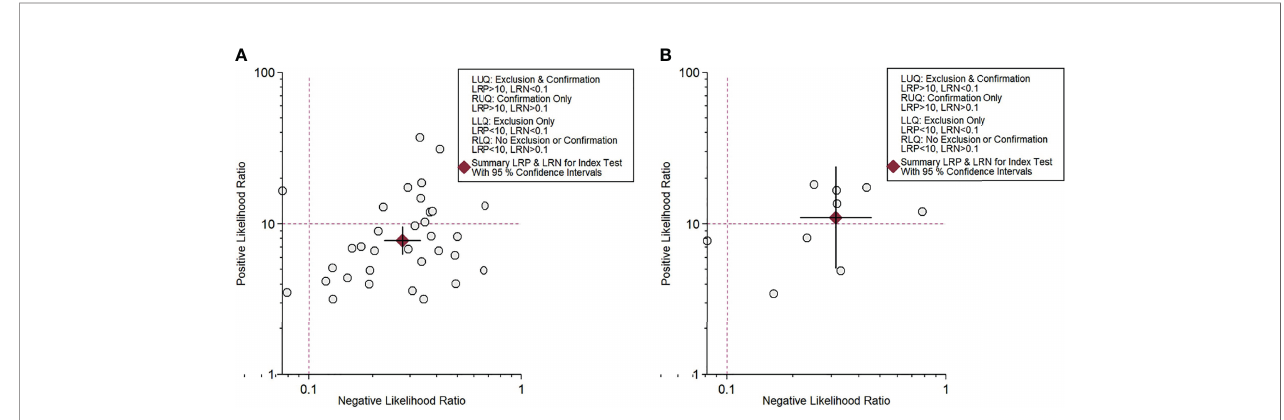
FIGURE 5 | Likelihood scattergram for contrast-enhanced MRI. (A) Gadoxetic acid-enhanced MRI. (B) ECA-MRI. ECA, extracellular contrast